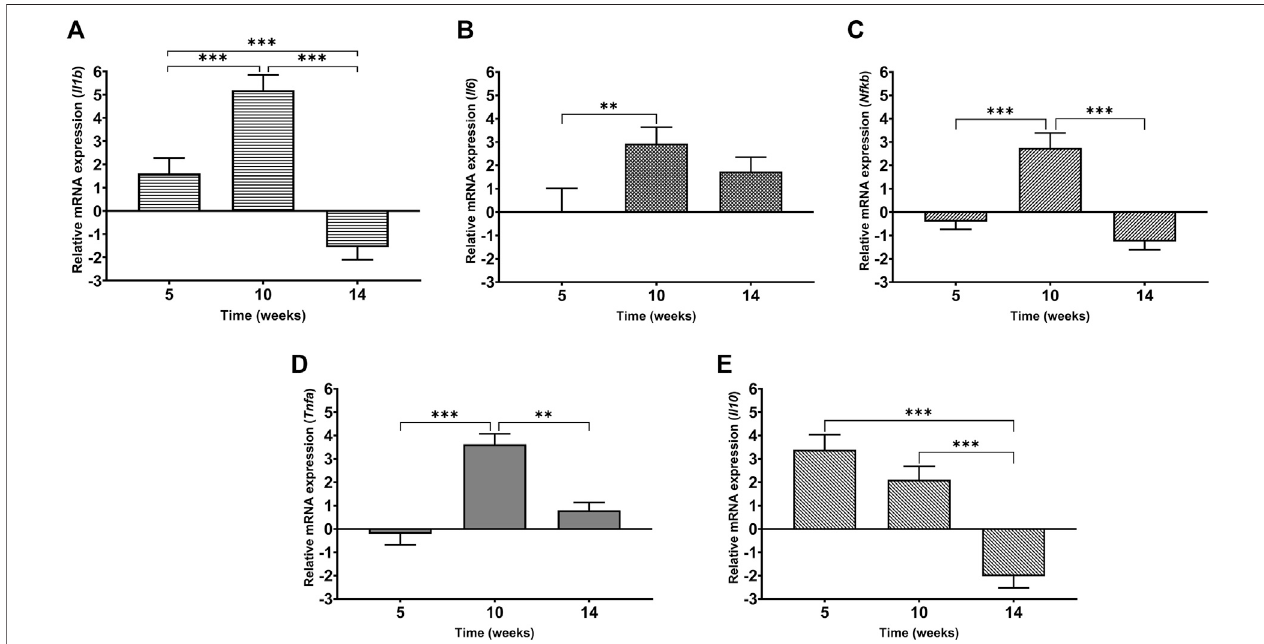
FIGURE 7 | Levels of mRNA expression of in fl ammatory mediators in heart tissue of Cd-treated male Sprague-Dawley rats using real time-PCR (A) IL-1 β (B) IL-6 (C) NF- κ B (D) TNF- α (E) IL-10. Expressiondataare represented asmean ± S.E.M ofrelative mRNA expression compared tothe control( n (cid:2) 8). *** p < 0.001,** p < 0.01.